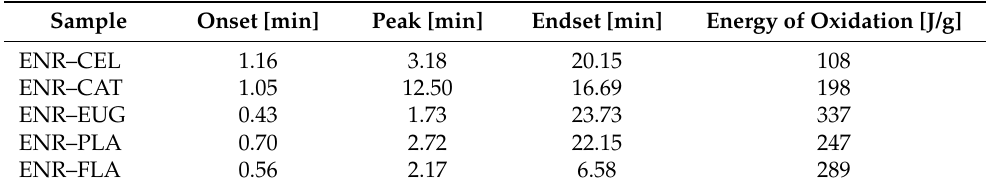
Table 3. Oxidation induction time values of ENR-based samples before aging and their energy of